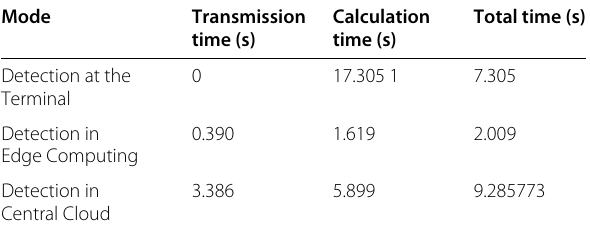
keys, etc. The structure of necessary equipment detection model based on Yolov3 model shown as in Fig.